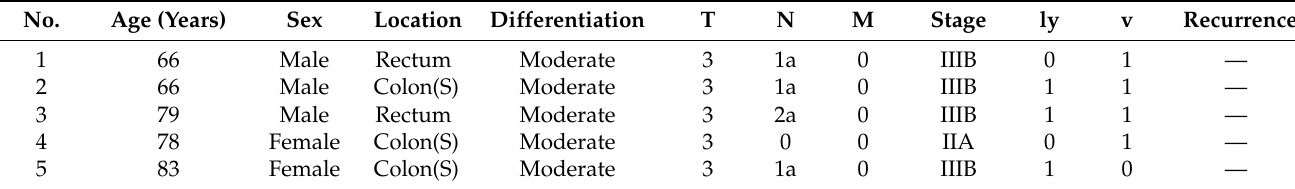
Table 1. Clinicopathological features of five colorectal cancer (CRC) patients whose CRC tissue and normal colorectal tissue were analyzed to generate the CRC miRNA signature.